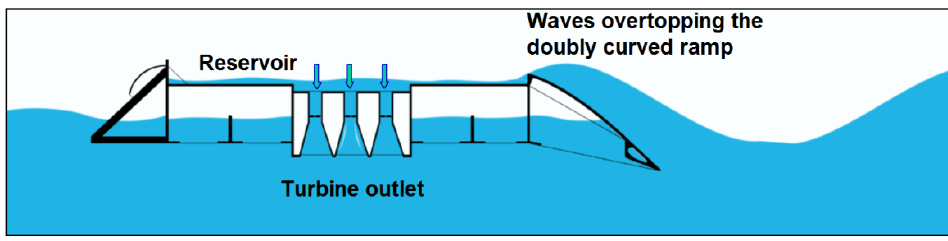
Figure 1. Working principle of the Wave Dragon wave energy